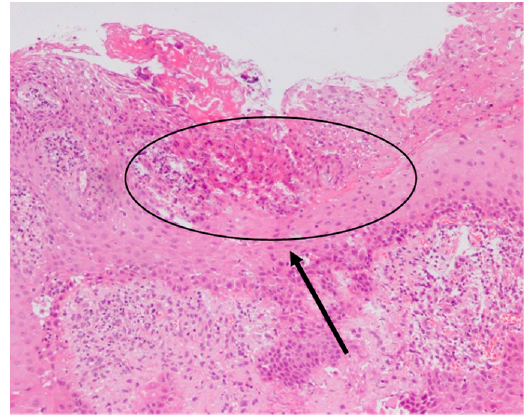
Figure 3. Light microscopy of 4 µm sections of the sulcular epithelial tissue of a patient with APE and stained with haematoxylin and eosin. In the circled area, it is possible to observe an extensive ulceration of the epithelium, a sign of severe inflammation at a magnification of 10 × .